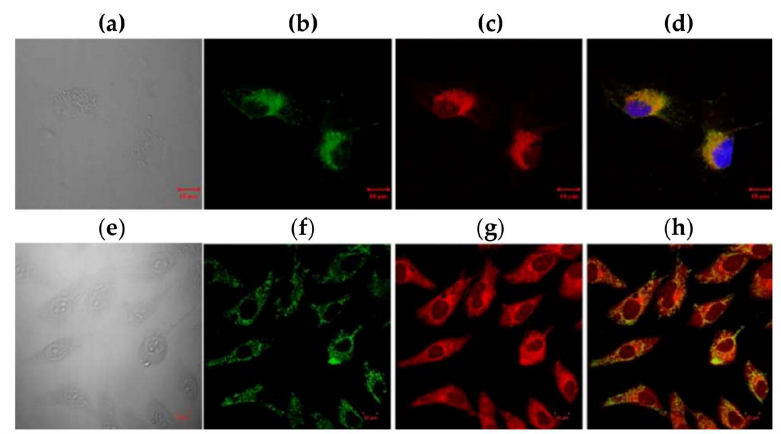
Figure 12. Confocal microscopic images of A549 cells after 4 h of incubation with 51 and 53 . The top panels: ( a ) bright field, ( b ) fluorescence of 51 , ( c ) fluorescence of Mitotracker deep red (MTR), ( d ) merged image of 51 , Mitotracker deep red and Hoechst. The bottom panels: ( e ) bright field, ( f ) fluorescence of Mitotracker green (MTG), ( g ) fluorescence of 53 , and ( h ) merged image of 53 and Mitotracker green. The overlap coefficient of 51 with Mitotracker red is ∼ 0.65, and that for 53 and Mitotracker green is ∼ 0.6. Scale bar represents 10 µ m. Adapted from